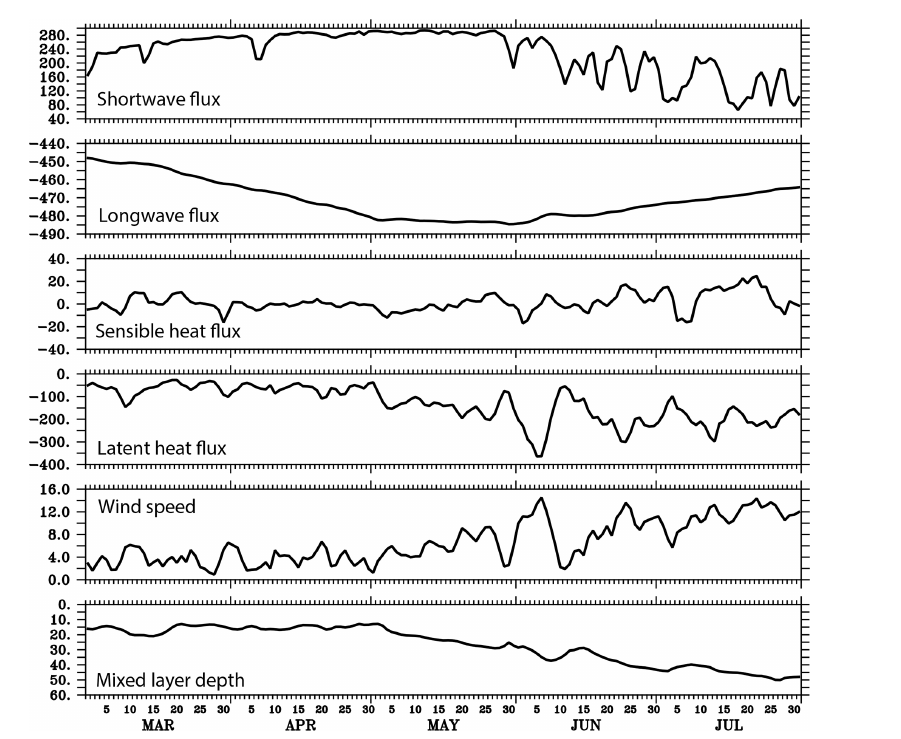
Figure 13. Surface heat fluxes, wind speed, and mixed-layer depth in the north–central Arabian Sea during March–June